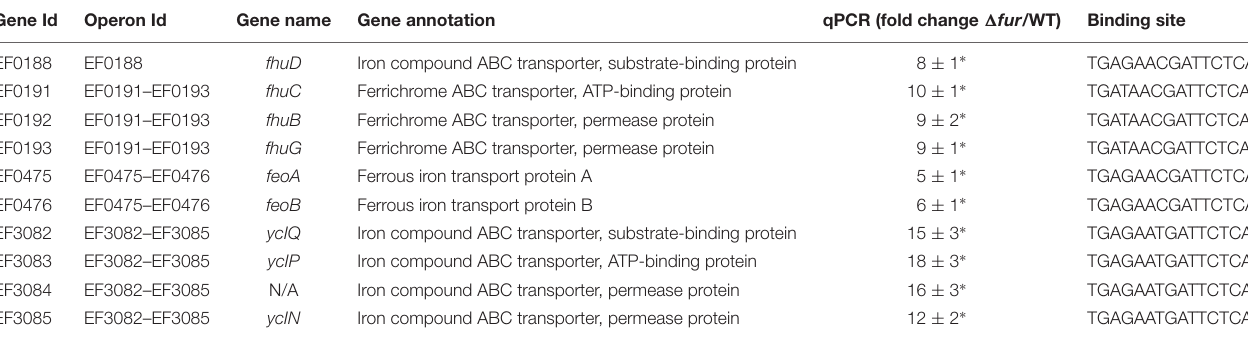
TABLE 1 | Changes in the relative abundance of Fur regulon genes.